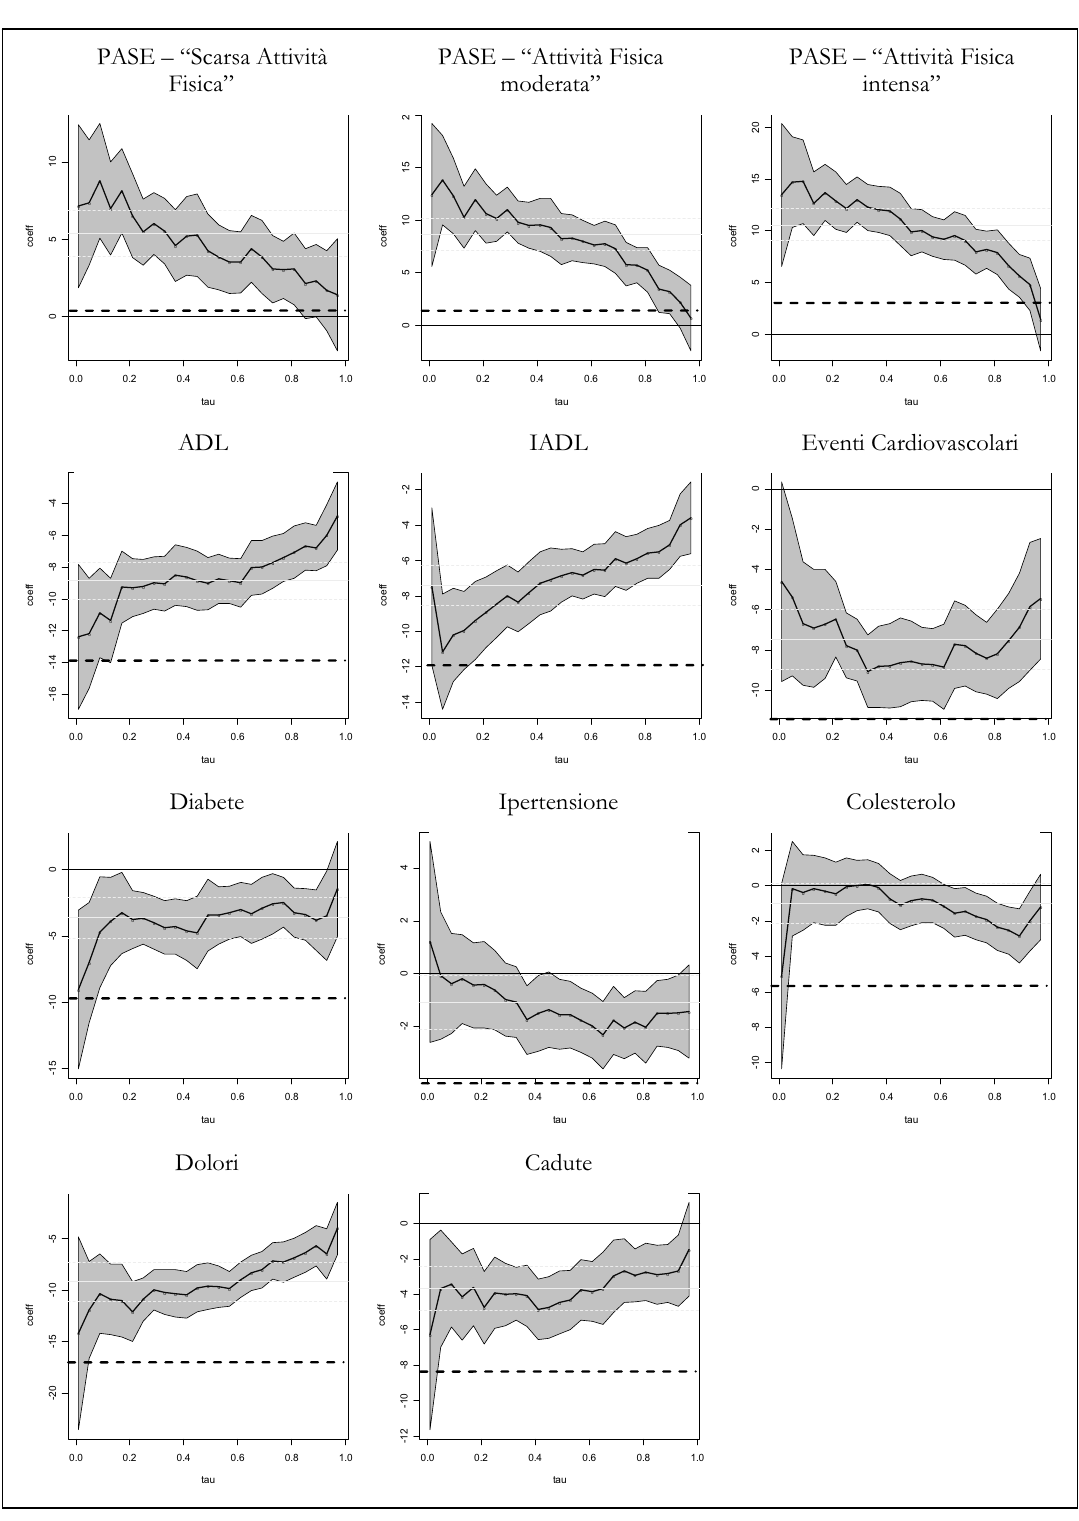
Figura 3 – Per singola covariata coefficienti di 99 regressioni quantili e relativi intervalli di confiden- za (bande grigie); coefficiente OLS (linee